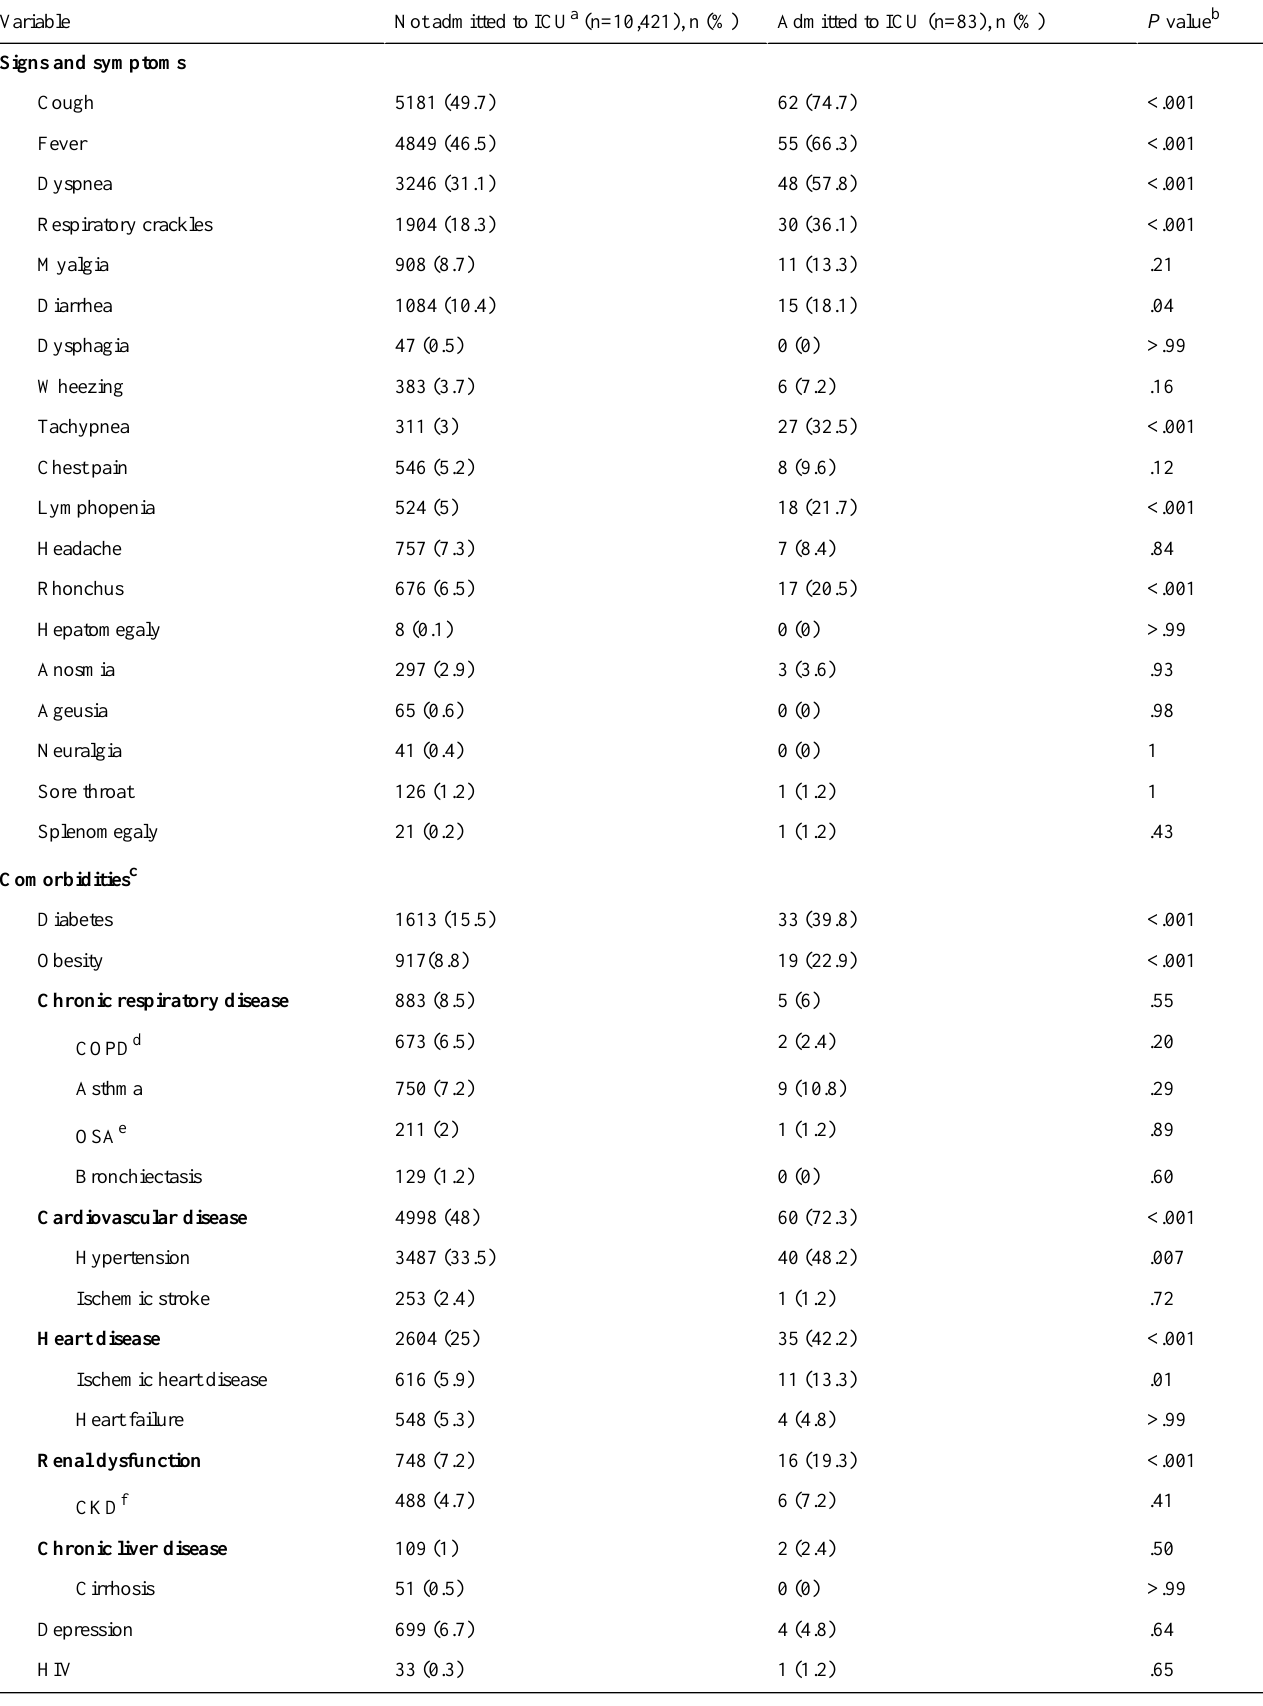
P value b Admitted to ICU (n=83), n (%)Not admitted to ICU a (n=10,421), n (%)Variable